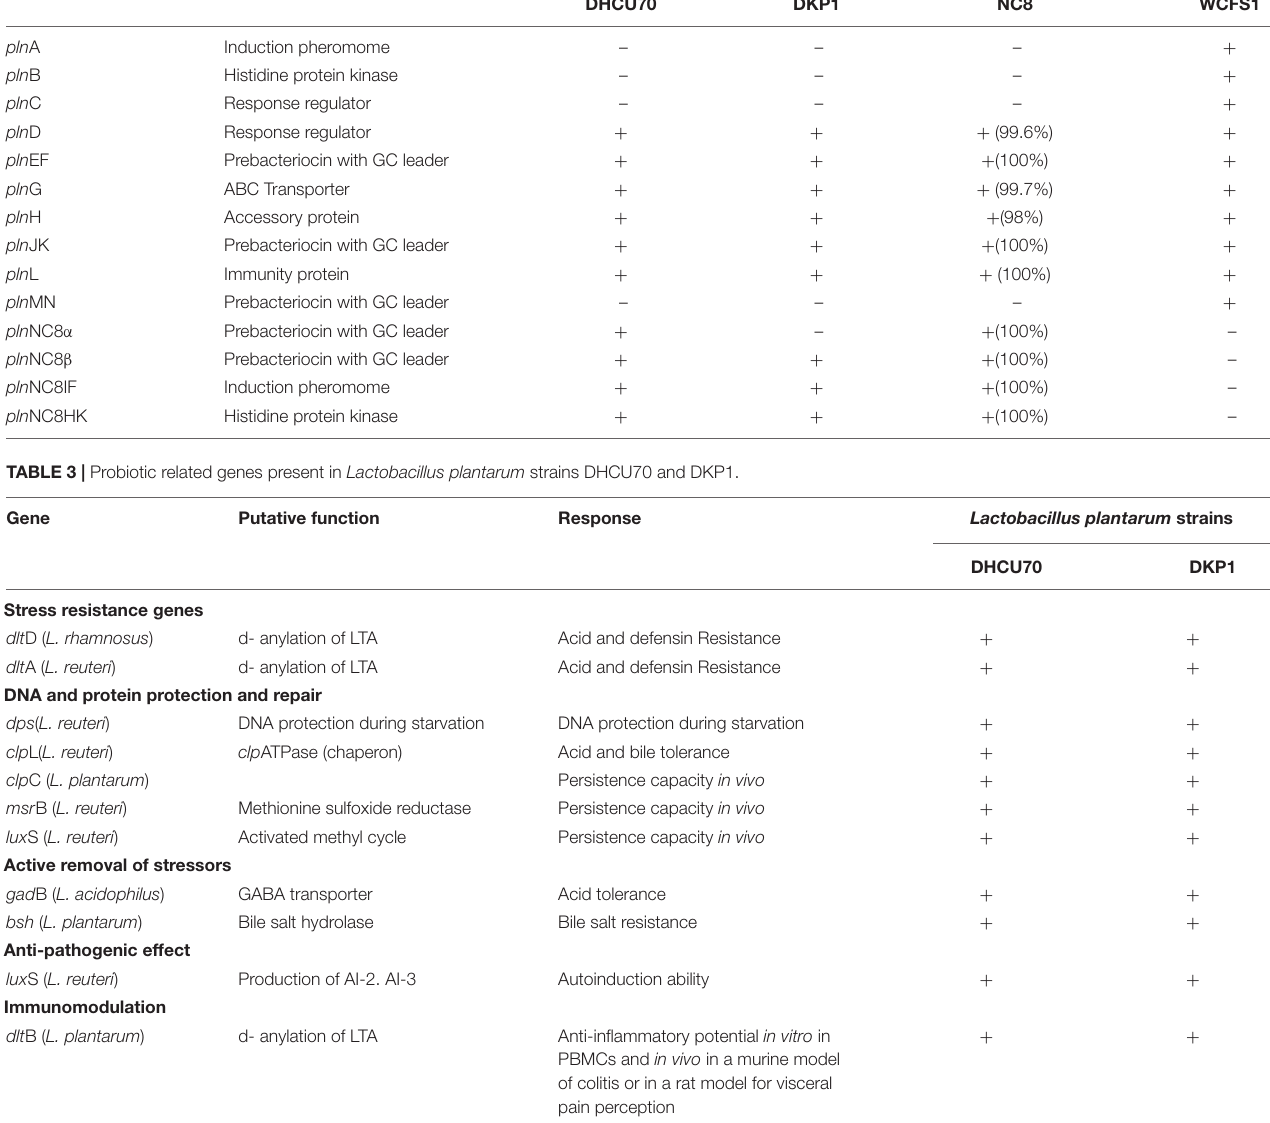
TABLE 2 | Comparison of pln genes of Lactobacillus plantarum strains DHCU70 and DKP1 with reference strains (NC8 and WCFS1). pln genes